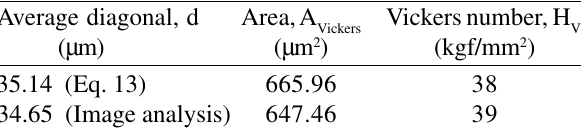
Table 5. Comparison of Vickers hardness number determined us- ing Eq. 11 with that measured by image analysis for an aluminum specimen. Load = 255 mN.